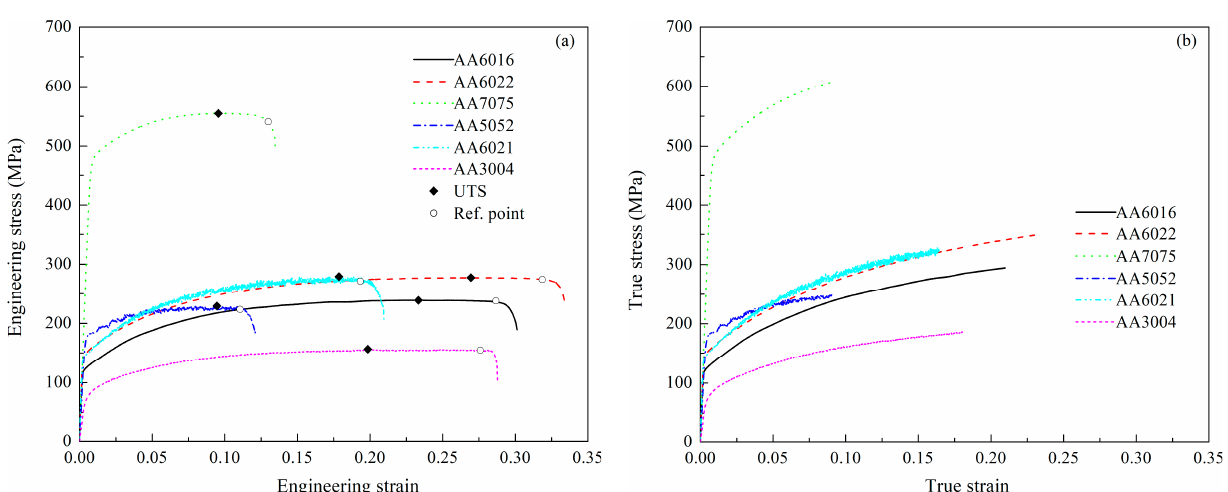
Figure 3. Stress-strain data obtained from uniaxial tensile tests for six steel sheets. ( a ) Engineering stress-strain curves. ( b ) True stress-strain curves.